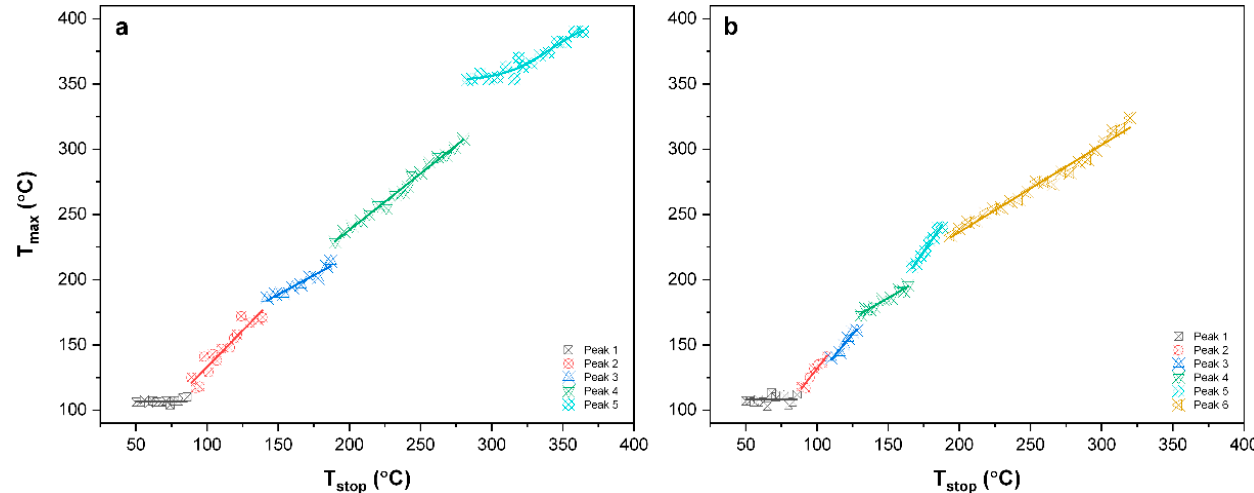
Figure 8. T max –T stop analysis for pure PPG ( a ) and terbium-doped ( b ) glass samples; irradiation dose 10 kGy per point, heating rate 2 °C/s.